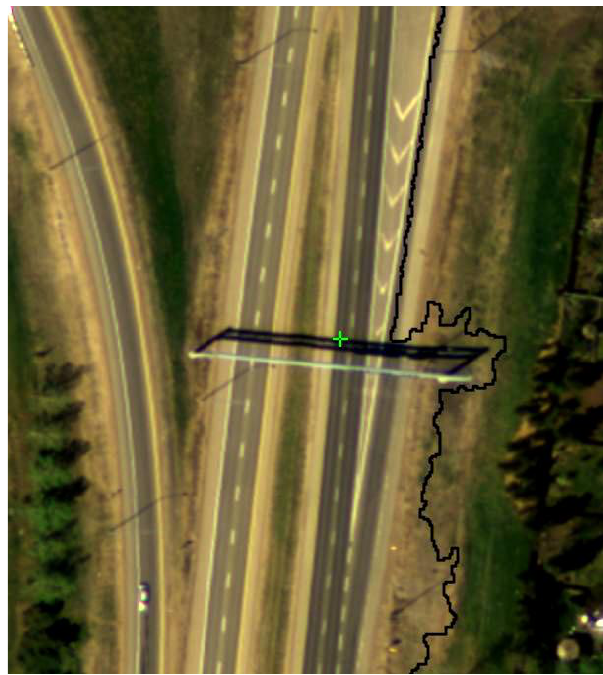
Figure 11.(a) An example seamline dodging a road